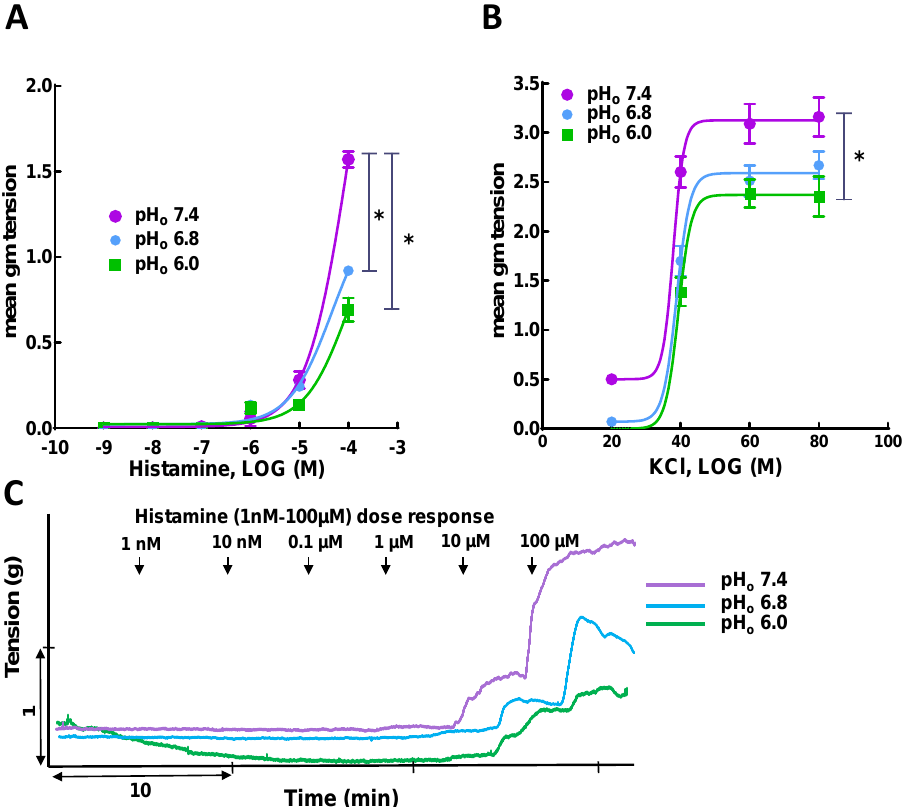
Figure 1. Effect of acidosis on agonist-induced contractile response in superior mesenteric artery (SMA): ( A ) Histamine-; ( B ) KCl-induced contractile responses in SMAs elicited at pH o 7.4 are attenuated with a leftward shift of the CRC at pH o 6.8 and 6.0; Representative tracing ( C ) showing histamine-induced contractile responses in SMA rings at pH o 7.4, 6.8, and 6.0. * p < 0.05, comparison vs. normal pH o (7.4), n =